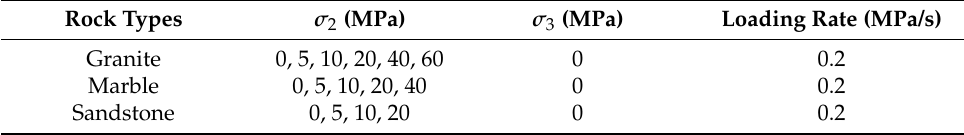
Table 1. Testing parameters in Path I.